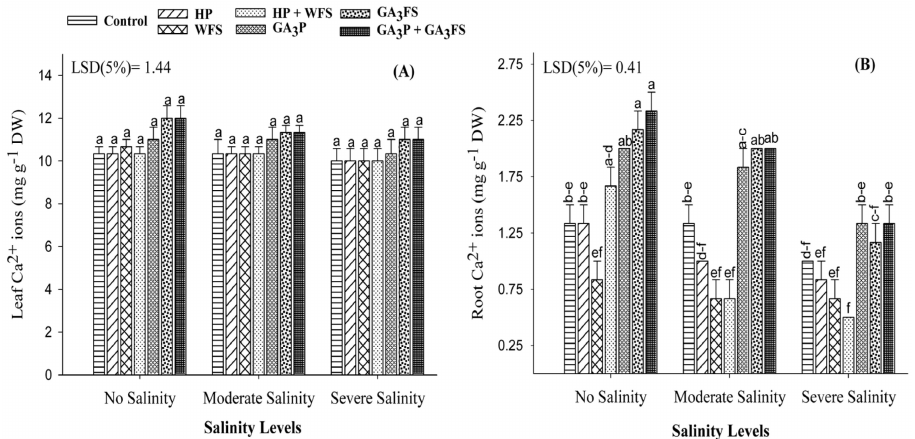
Figure 9. Calcium (Ca 2+ ) ions in maize shoots ( A ) and roots ( B ) as affected by different treatments of gibberellic acid under no salinity (control), moderate salinity (6 dS m − 1 ), and severe salinity (12 dS m − 1 ). Values are means ± SD (n = 3). Hydropriming (HP); water foliar spray (WFS); hydropriming and water foliar spray (HP + WFS); seed priming with GA 3 (GA 3 P); foliar spray with GA 3 (GA 3 FS); seed priming and foliar spray of GA 3 (GA 3 P + GA 3 FS). Bars with the same letters do not differ significantly at p ≤